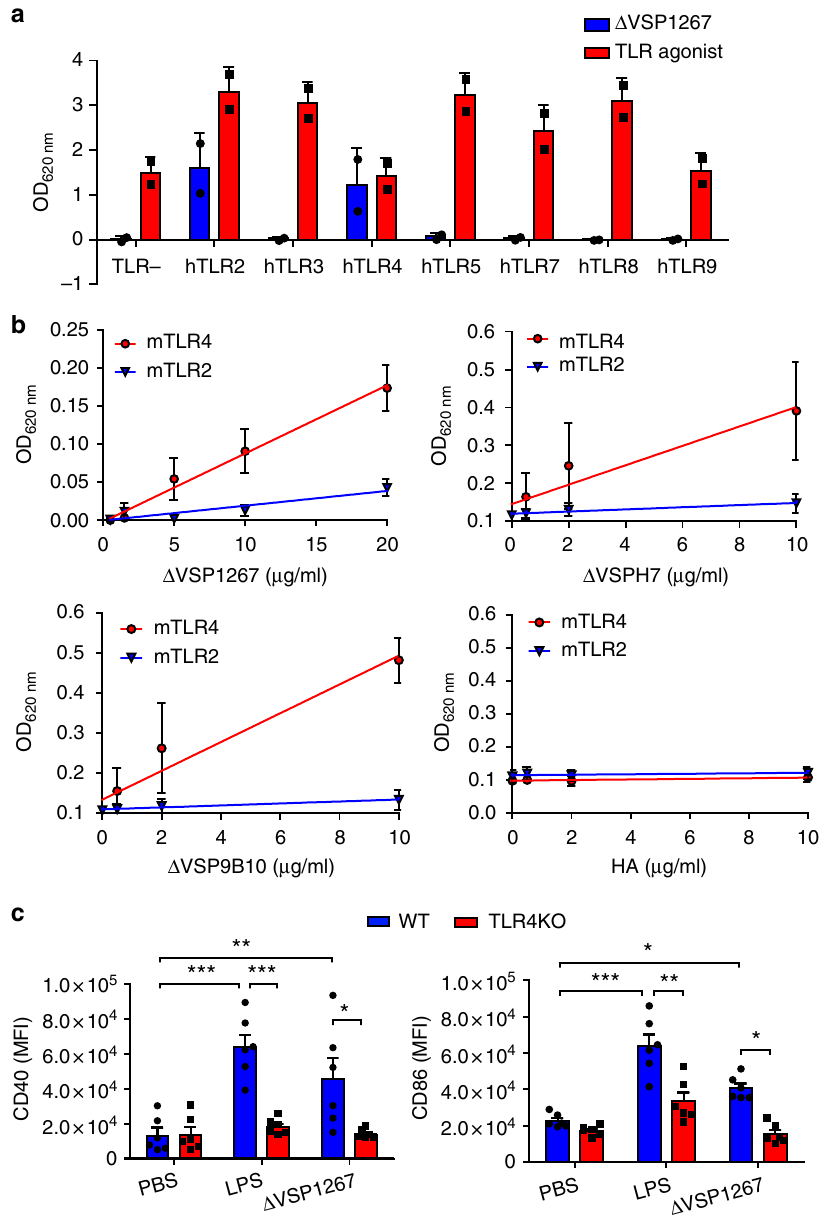
Fig. 2 Immunogenic properties of different Giardia VSPs. a Activation of a panel of human TLR reporter cells (hTLR) by Δ VSP1267 (20 μ g ml − 1 ). Reporter cells were incubated with the recombinant protein and the secretion of SEAP was recorded. Speci fi c TLR agonists were employed as positive controls (hTLR-2: Pam2CysK4, hTLR-3: PolyI:C, hTLR-4: LPSK12, hTLR-5: fl agellin, hTLR-7: R848, hTLR-8: R848, hTLR-9: ODN2006). The parental cell line was used as negative control (TLR-). b Activation of mouse TLR-4 and TLR-2 reporter cell lines (mTLR) by Δ VSP1267, Δ VSPH7, Δ VSP9B10, and recombinant HA (H5N1). * p < 0.05 Δ VSPH7 and Δ VSP9B10 for TLR-4, ** p < 0.01 Δ VSP1267 for TLR-4 and TLR-2; Linear regression test, n = 6 from three independent experiments. c In vitro stimulation of BMDCs. C57BL/6 WT and TLR-4 KO BMDCs were incubated in vitro with PBS, LPS (500 ng ml − 1 ) or Δ VSP1267 (50 μ g ml − 1 ), and CD40 and CD86 levels were measured by fl ow cytometry (MFI: mean fl uorescence intensity). * p < 0.05, ** p < 0.01, *** p < 0.001; two-way ANOVA, Bonferroni post-tests, n = 6 from three independent experiments. Values represent mean ± s.e.m. Source data are provided as